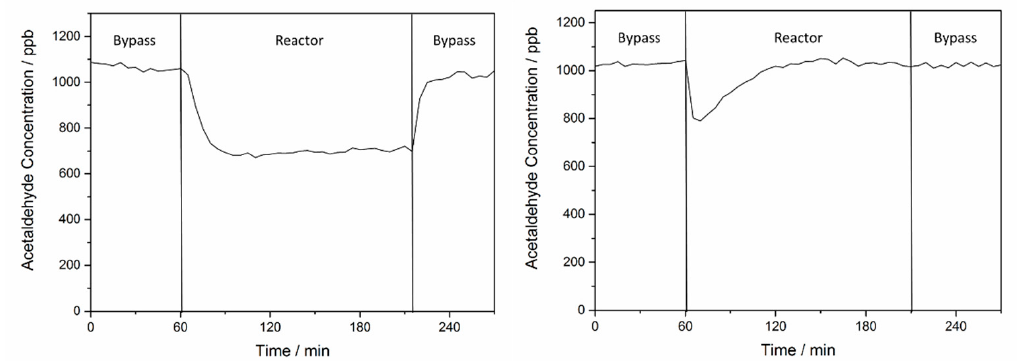
Figure 2. The concentration of acetaldehyde as a function of time, under dry ( Left ) and humid ( Right ) conditions, in air and in the dark. During the first 60 min, the gas flow was held constant, in bypass mode. Afterward, it was directed over a TiO 2 film, for 2.5 h, in the dark, before it was turned back to the bypass mode again.